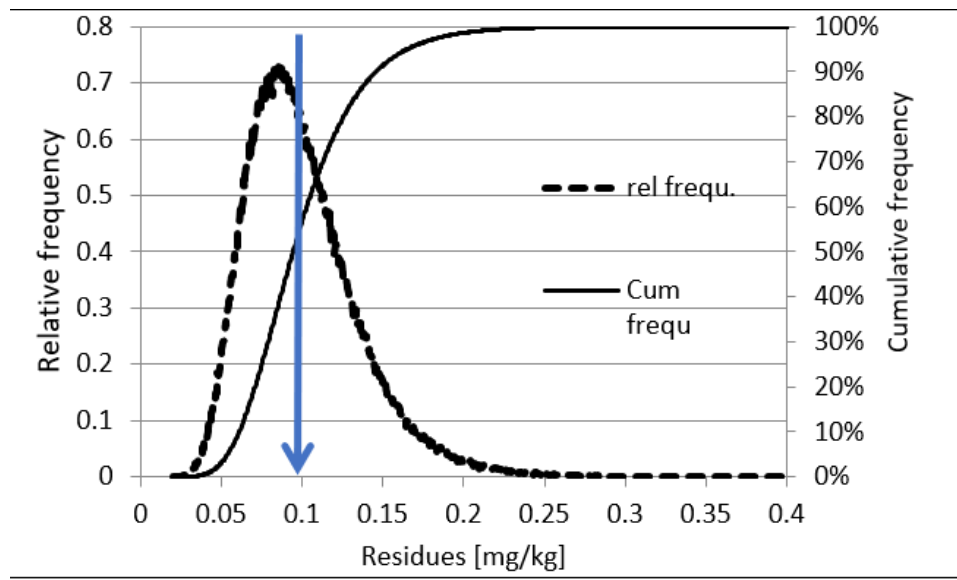
Figure 8. Distribution of residues in apple composite samples taken from a lot with mean residue of 0.11 mg/kg and CV R of 0.35. The MRL of 0.1 mg/kg is indicated by the blue arrow.